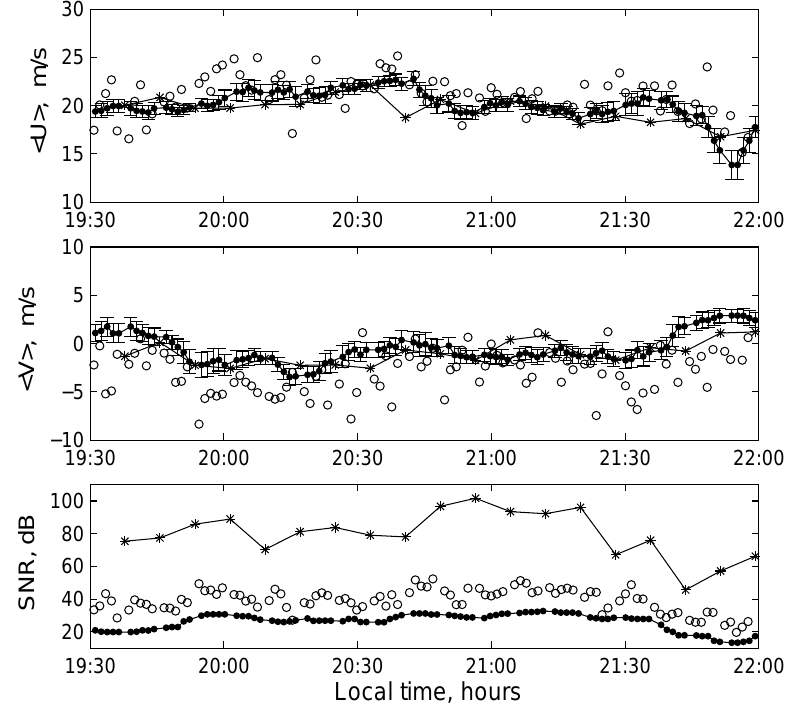
D E D E U V and northerly mean wind speed components and SNR on 24 April 2002 at z o = 5 . 1km. • , STARS;